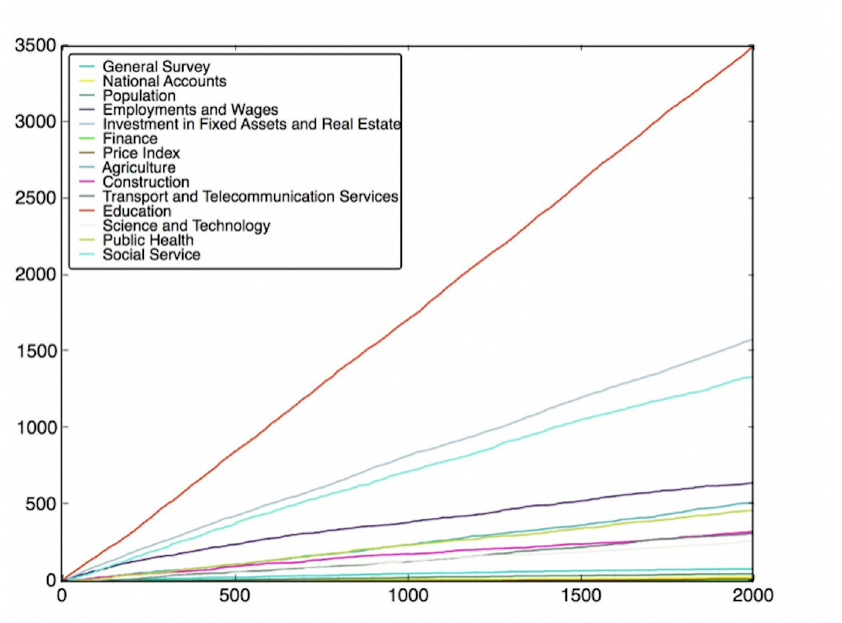
Fig 12. SVR with 5 features and clustering method.